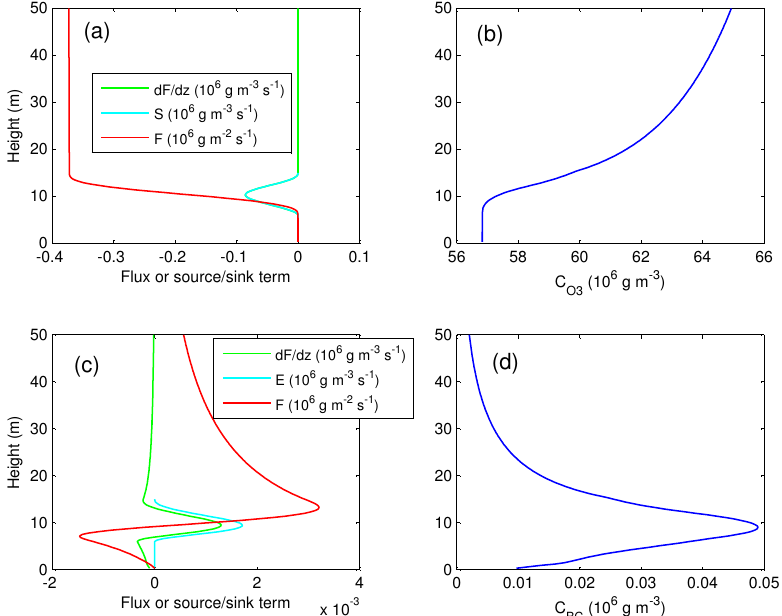
Fig. 10. Vertical profiles of modelled ozone ( C O , panel b ) and β -caryophyllene ( C β - C , panel d ) concentrations and vertical turbulent fluxes 3 ( F ), turbulent flux gradients (d F /d z ) and source (for β -caryophyllene the emission denoted by S e ) or sink (for O 3 stomatal sink denoted by S ) terms for (a) O 3 and (c) β -caryophyllene. Temperature 20 ◦ C and emission potential 385ngg − 1 (dw)h − 1 was assumed; C O 30ppb as the boundary condition for ozone concentration was applied; radiation above canopy was taken as I b , h = 800µmolm − 2 s − 1 and I d , h = 200µmolm − 2 s − 1 ; following optimal stomatal model parameters were used: α = 0 . 0012ms − 1 , γ = 2200µmolm − 2 s − 1 , λ = 4 × 10 − 3 gCO 2 (gH 2 O) − 1 . Atmospheric boundary layer height was set to